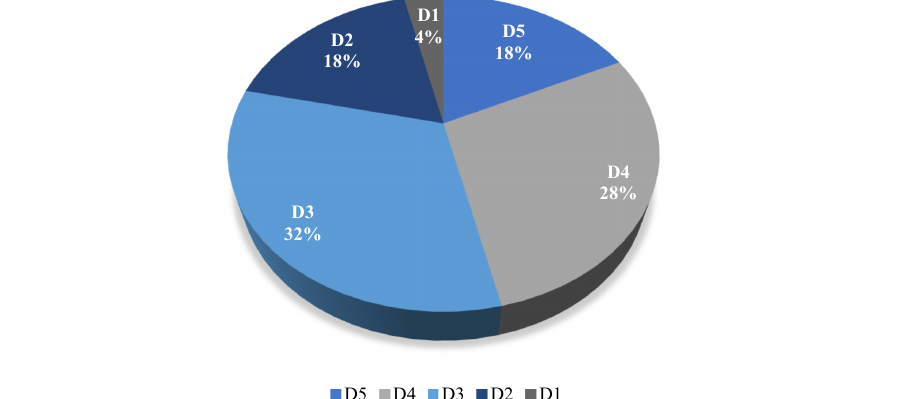
Figure 2. Each damage state categorised for the selected earthquake